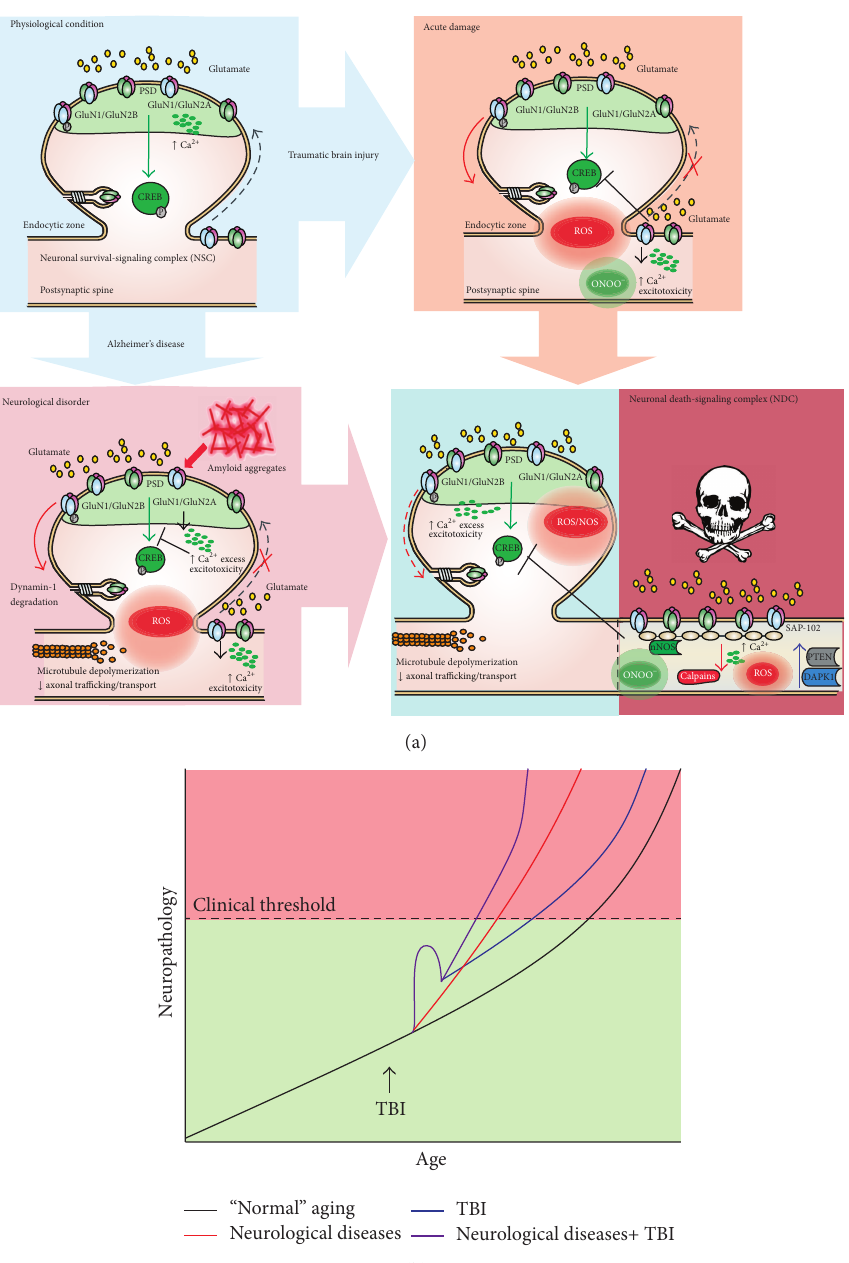
Figure 2: Dysregulation of NMDARs performance in neuropsychiatric disorders and in acute damage. (a) Schematic of the role of NMDARs in TBI and neurodegenerative disease. Under physiological conditions, synaptic NMDARs are activated as well as antiapoptotic cell pathways preventing excitotoxicity by targeting CREB. After acute damage, including TBI, there is a decrease in CREB activation, increased activation of extrasynaptic NMDARs, and ROS/NOS generation. In neurological disorders such as AD, there are alterations in cell signaling due to misfolding proteins, microtubule depolymerization, excessive Ca 2+ influx, ROS generation, and excitotoxicity. The cell death mechanisms associated with glutamatergic transmission include calpains, PTEN, and DAPK1. (b) Hypothesized interaction between TBI, neurological diseases, and “normal” aging. The progression curves show the age of patients at disease onset and the severity of neurological symptoms. The black line shows the progression of neurodegeneration in normal aging and the red line shows the acceleration of neurodegeneration that occurs in diseases such as AD. This neurodegeneration includes neuroinflammation, oxidative stress markers accumulation, and the aggregation of misfolded proteins. This neurodegeneration can be accelerated after TBI both in “normal aging” (blue line) and in patients with neurodegenerative disease (purple